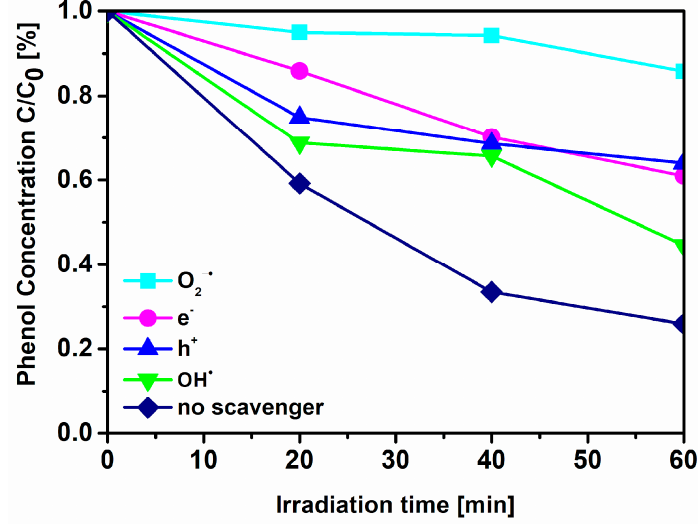
Figure 10. Effects of different scavengers on the effectiveness of phenol degradation under visible irradiation ( λ > 420 nm) in the presence of the TPTZ(1:10)_TiO 2 _24 h irradiation ( λ > 420 nm) in the presence of the TPTZ(1:10)_TiO 2 _24 h sample.